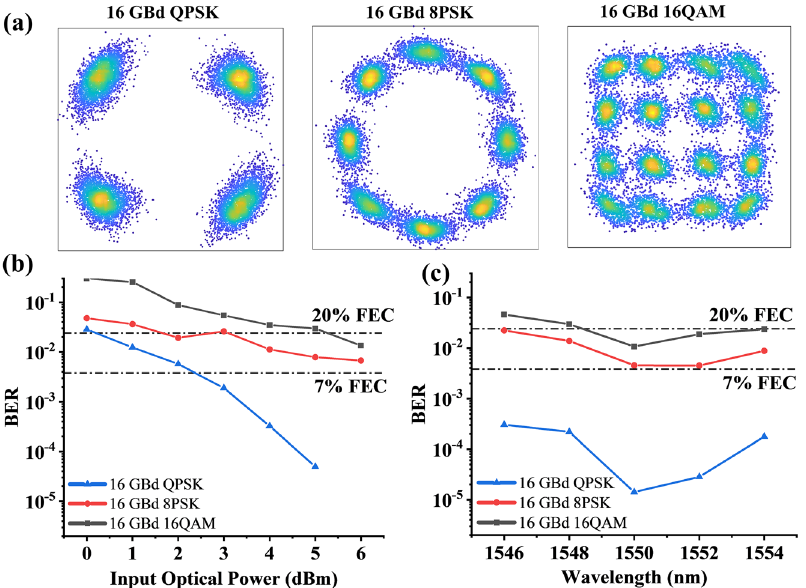
Figure 4: High-speed Stokes vector direct detection